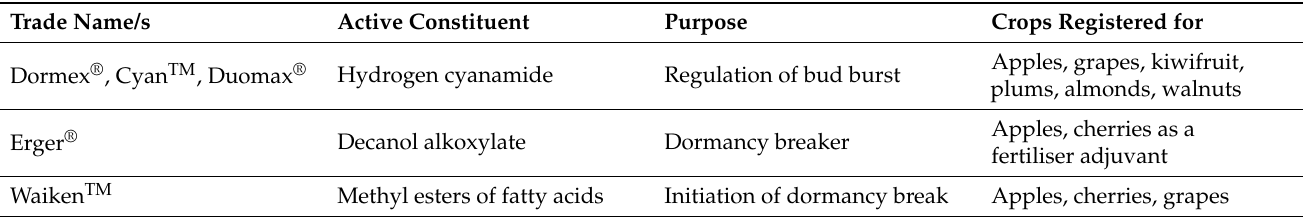
Figure 1. Flowering times for nashi in Orange, NSW, in relation to the European pear cultivar ‘Packhams’ Triumph’ (adapted from NSW DPI, https://www.dpi.nsw.gov.au/agriculture/horticulture/pomes/other/nashi (accessed on 26 August 2021)). Table 2. Dormancy-breaking products available in Australia. Note that none of these chemicals have label recommendations for pears or